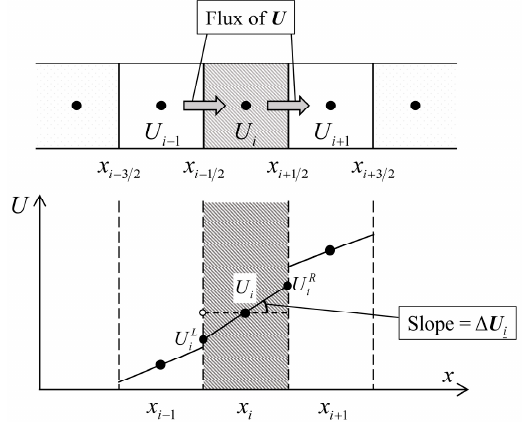
Figure 3. Schematic sketch of the locations of variables in Equation (16).